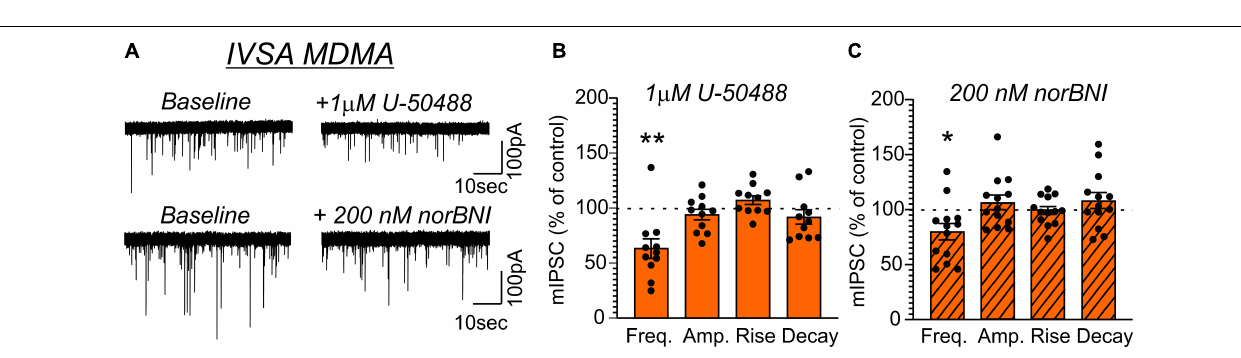
Frontiers in Behavioral Neuroscience |